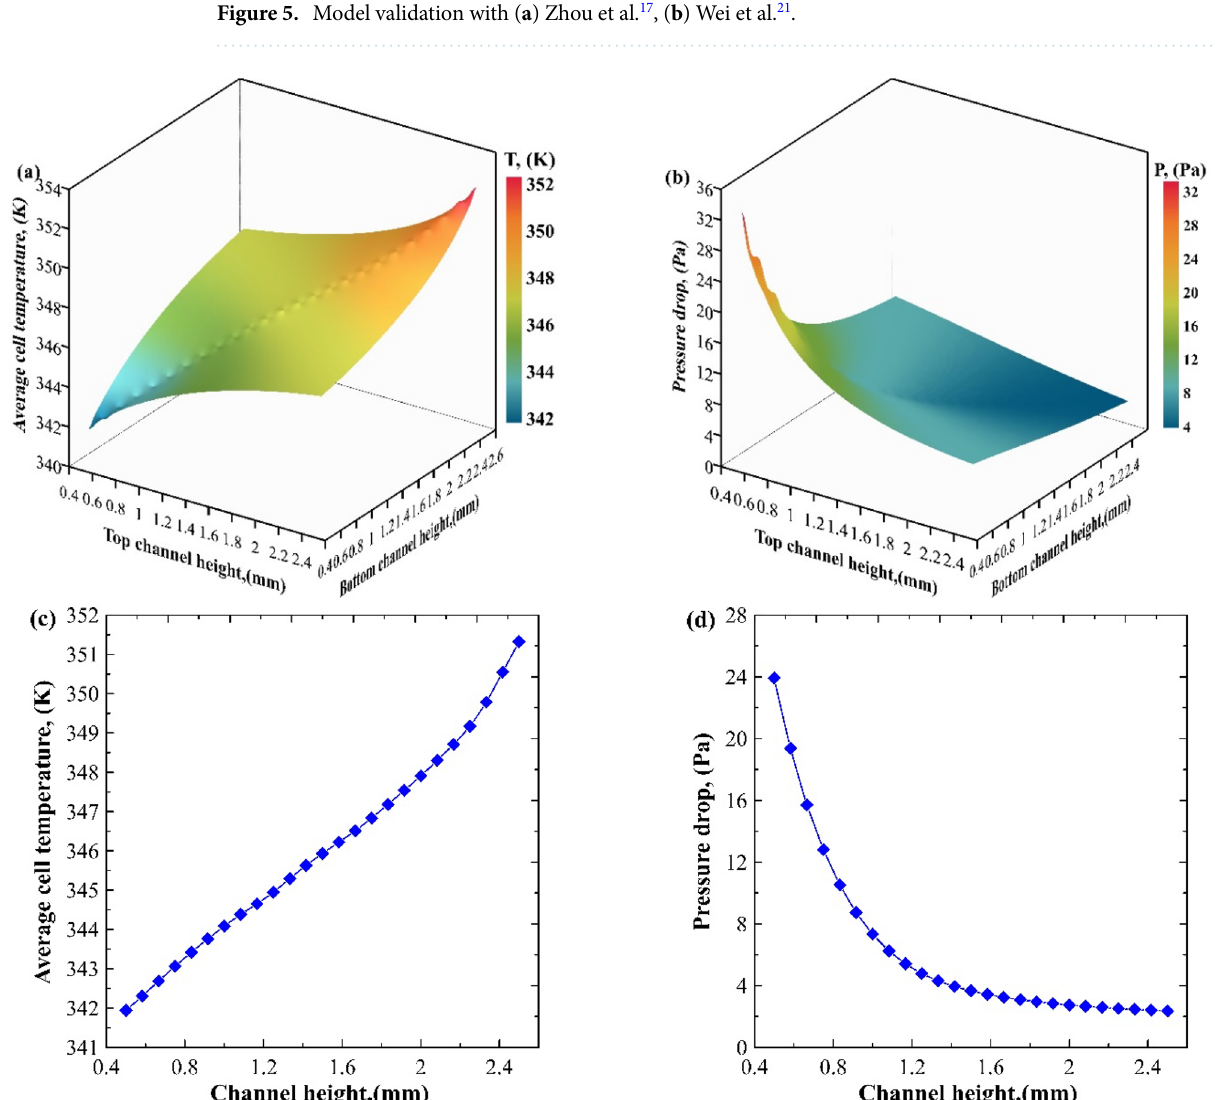
Figure 6. Surface response for temperature and